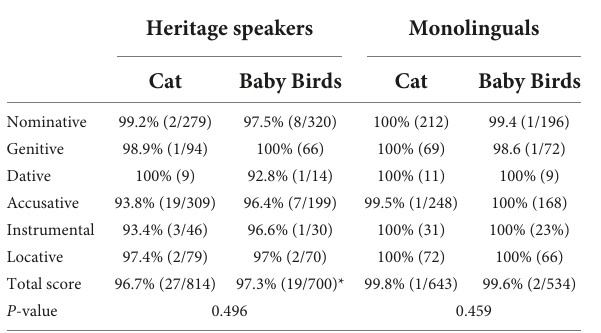
TABLE 5 Case marking raw scores and percentages per condition and story.